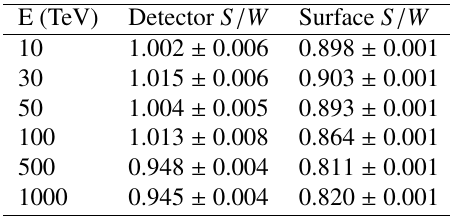
Table 2: Ratios of the summer and winter muon flux for showers at θ = 50 ◦ and di ff erent energies, measured at the detector and the surface planes,